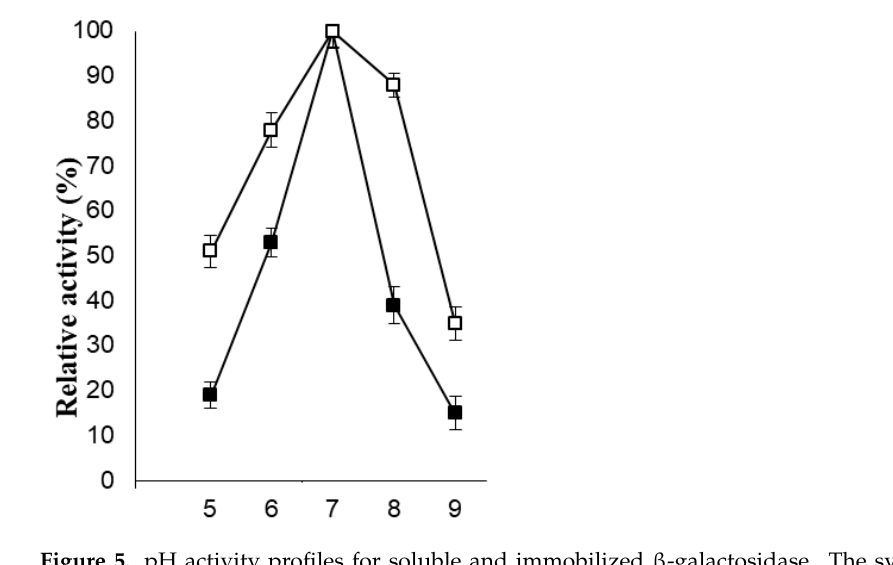
Figure 5. pH activity profiles for soluble and immobilized β -galactosidase. The symbols show soluble ( ■ ) and immobilized ( □ ) β -galactosidase.